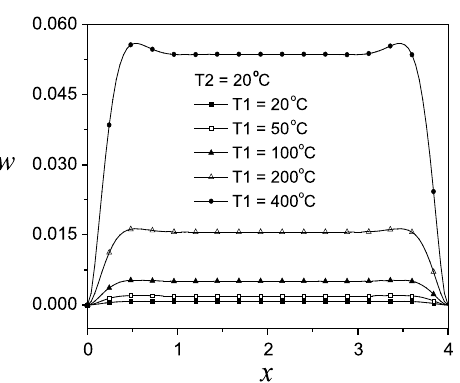
Fig. 7. Deflection of the mid-plane for the clamped supported FGPM cylindrical shell under different electric fields ( q = 1 MPa,